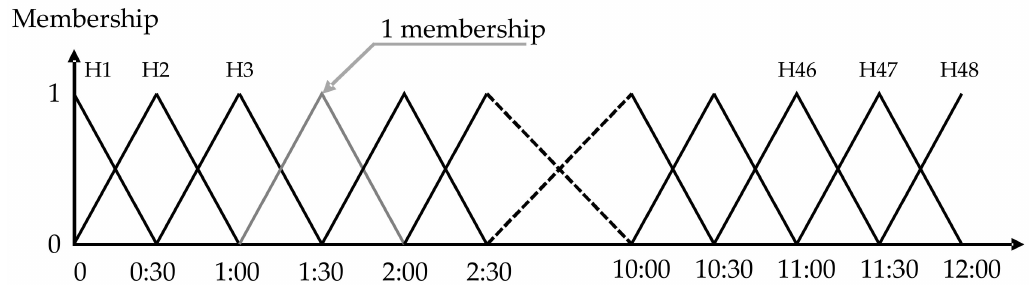
Figure 13. Example of triangular membership functions for the first input of the model